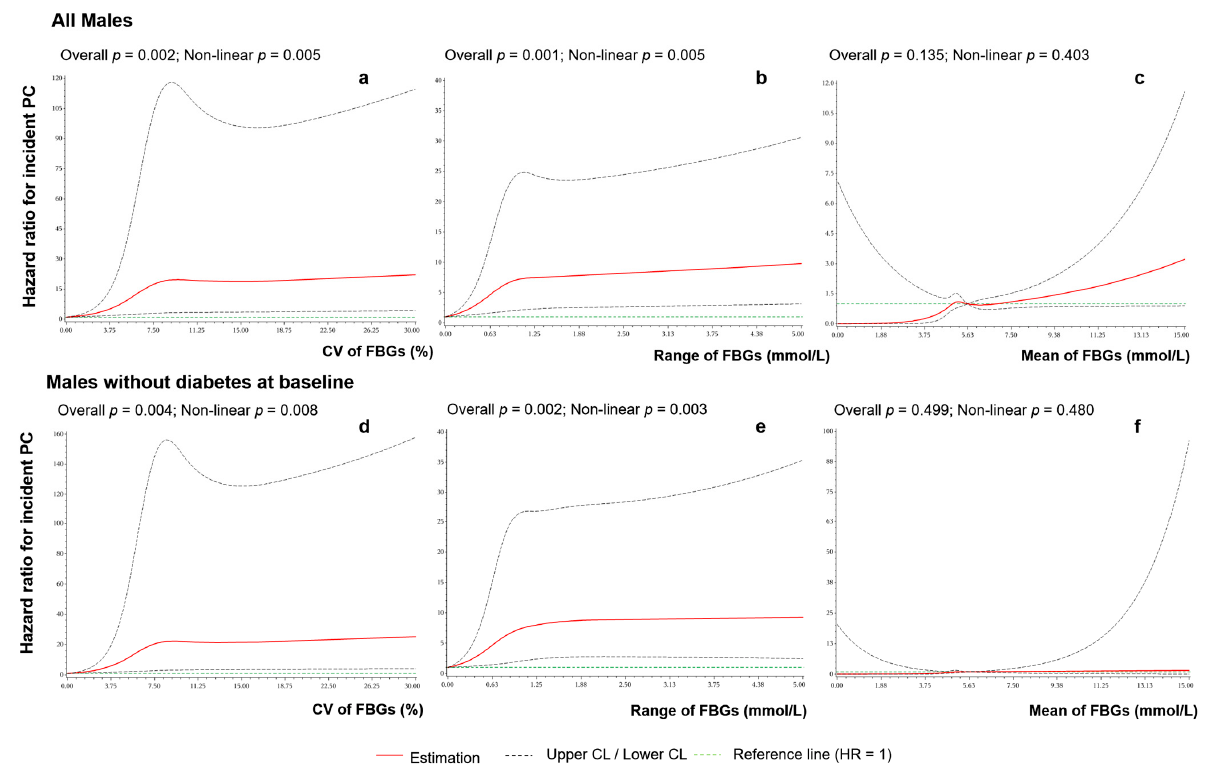
Figure 2. Non-linear associations between FBG stability and the risk of PC. ( a ) CV of FBGs in all males, ( b ) range of FBGs in all males, ( c ) mean of FBGs in all males, ( d ) CV of FBGs in males without diabetes, ( e ) range of FBGs in males without diabetes, and ( f ) mean of FBGs in males without diabetes.